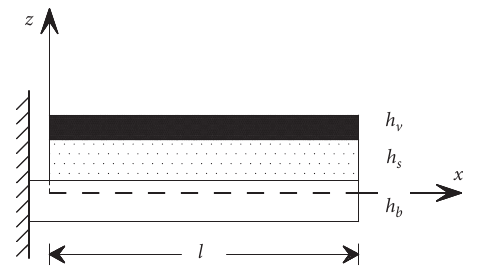
Figure 1: Structural model of the stand-off free layer damping cantilever